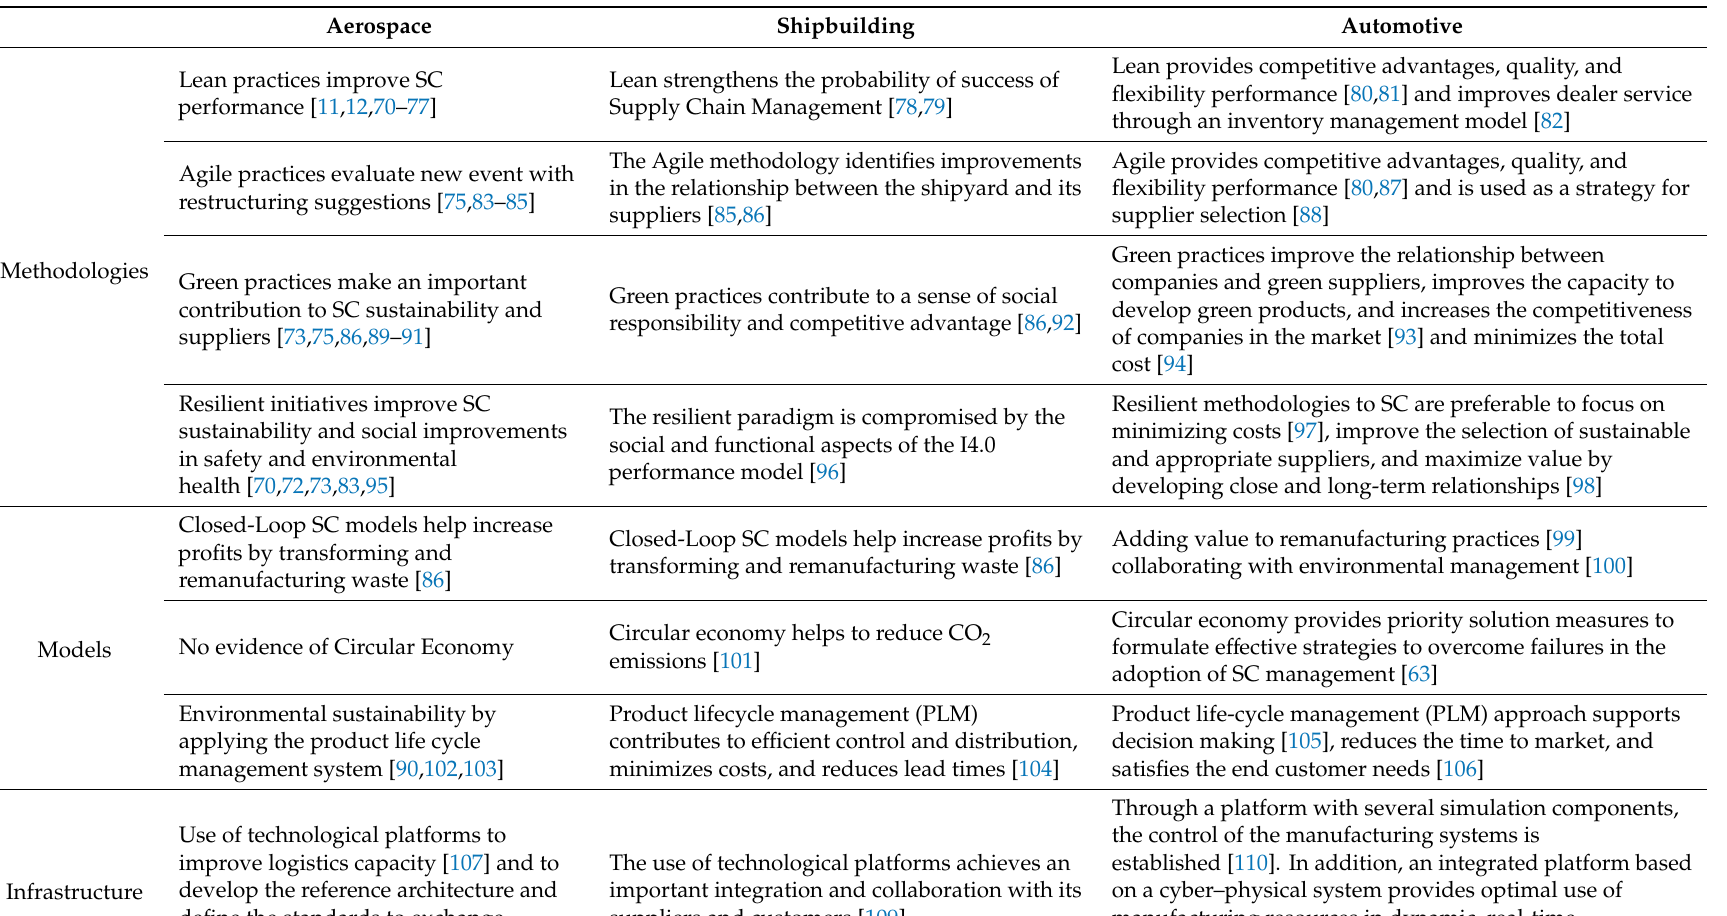
Table 1. Comparison of SC